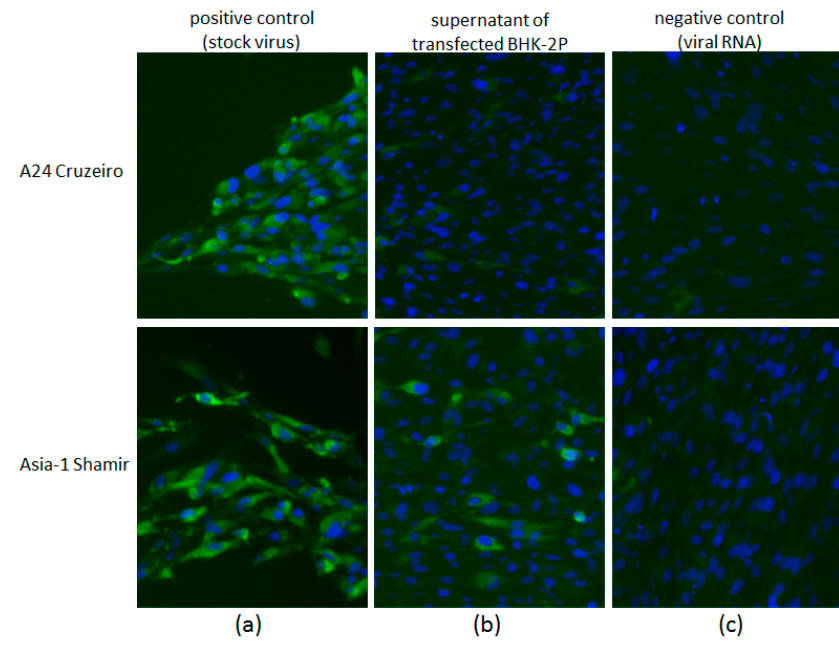
Figure 4. Detection of FMDV antigen in adherent BHK164 after treatment with supernatant from transfected BHK-2P. Adherent BHK164 were incubated with stock virus, clarified supernatant from transfected BHK-2P, or viral RNA for 4 h at 37 ◦ C, then fixed and stained with serum from FMDV-infected cattle (green staining). Cell nuclei are shown in blue ( a ) Cells infected with A 24 Cruzeiro and Asia-1 Shamir stock virus as positive controls (PC); ( b ) Cells incubated with supernatant from transfected BHK-2P; ( c ) Cells incubated with viral RNA alone (no transfection reagent) as negative controls (NC).